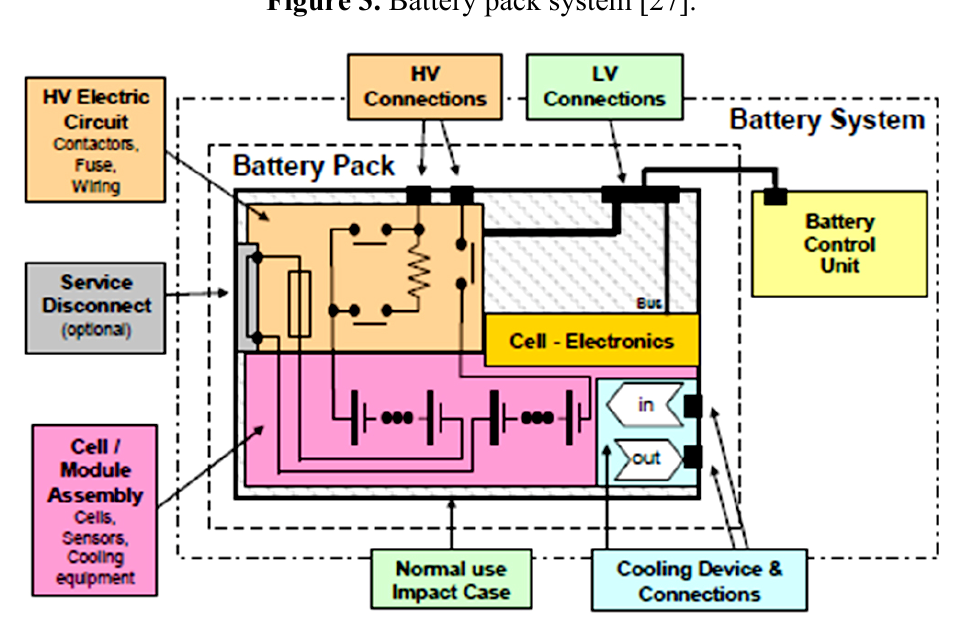
Figure 3. Battery pack system [ 27 ]